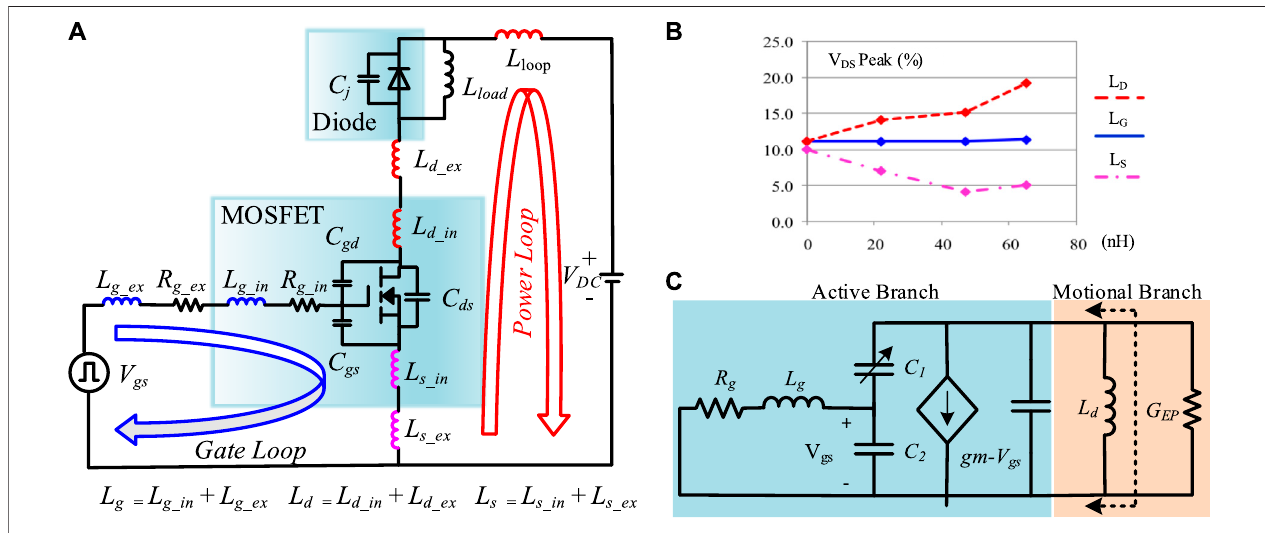
FIGURE 3 | (A) Double pulse test (DPT) circuit (Liu et al., 2018b) (B) Effect of different parasitic inductances on the drain to source voltage ( V ds ) under the testing condition of 400 V and 10 A (Chen, 2009) (C) Equivalent small-signal model of DPT to investigate sustained oscillations (Lemmon et al., 2014).